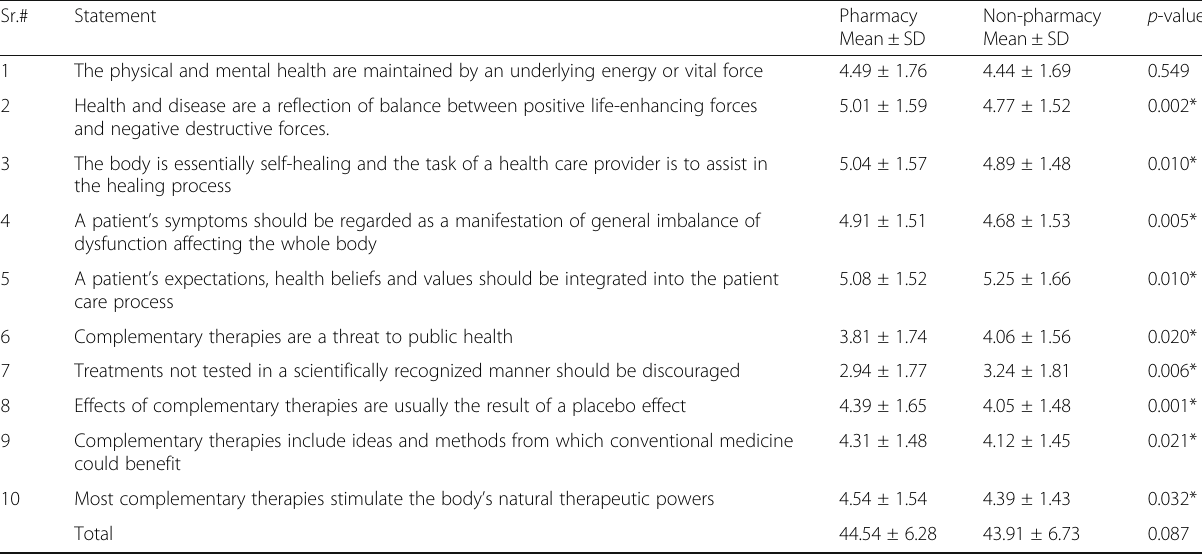
Table 5 CAM Health Belief Scores Using CHBQ Questionnaire